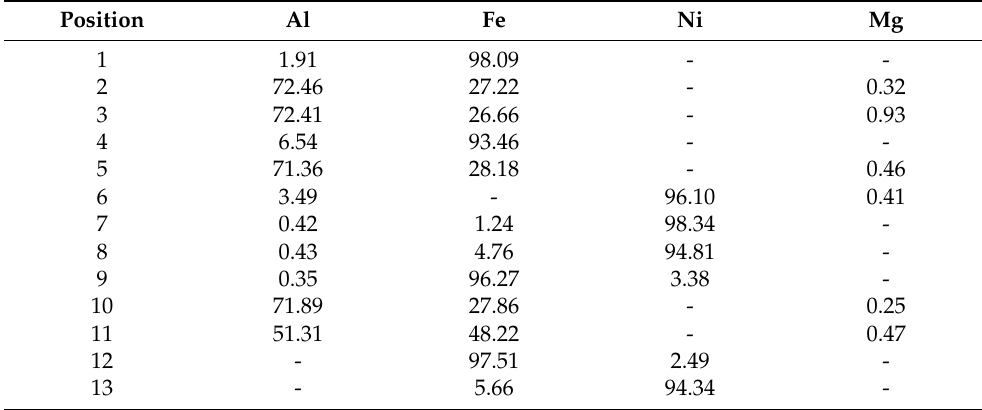
Table 3. Results of EPMA point analyses at various positions (at. %).